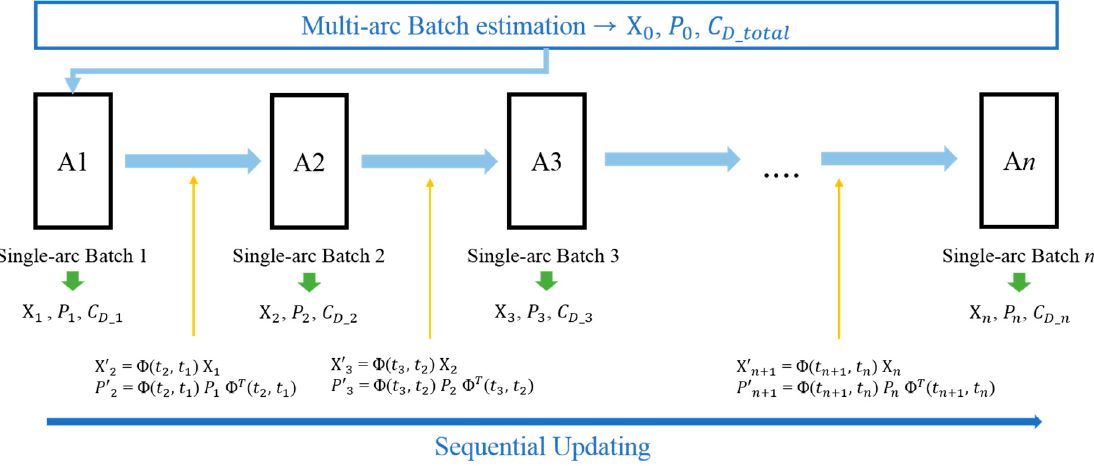
Figure 9. Sequential-batch orbit estimation diagram. In the multi-arc batch orbit estimation step, the position and velocity vectors and the single atmospheric drag coefficient are estimated by optical observation data epochs. After that, batch orbit estimations for single short-arcs are conducted by sequentially estimating the atmospheric drag coefficient. The position, velocity, and covariance were propagated to the next short arcs with results from the present short-arc batch orbit estimation.